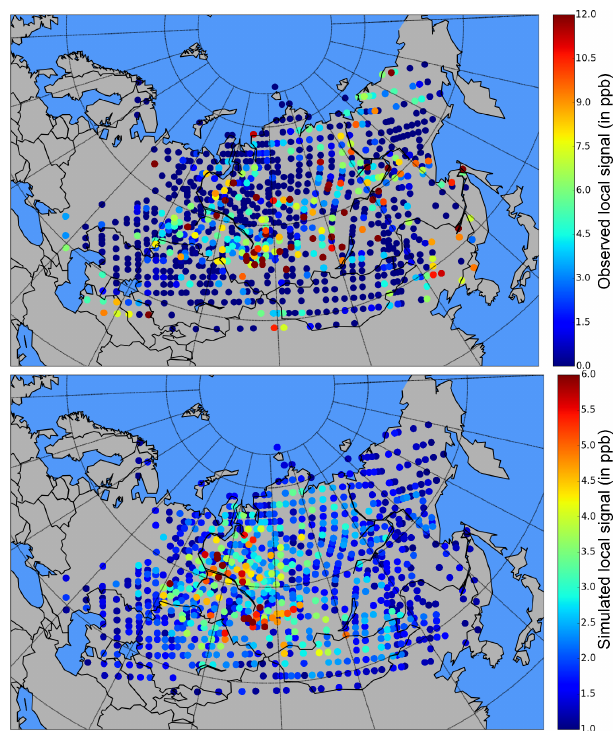
Figure 8. Observed (top) and simulated (bottom) contributions of the local Siberian sources to GOSAT total columns (inppb). The observed contribution of local sources are selected as excesses from the regional measured background (defined as the average observed total column in a zone of roughly 2000km in the zonal direction and 1000km in the meridional one). The simulated contributions are computed from CHIMERE forward simulations of the emissions of the Siberian lowlands. The colour scale is not the same between the two panels in order to facilitate the readability of the